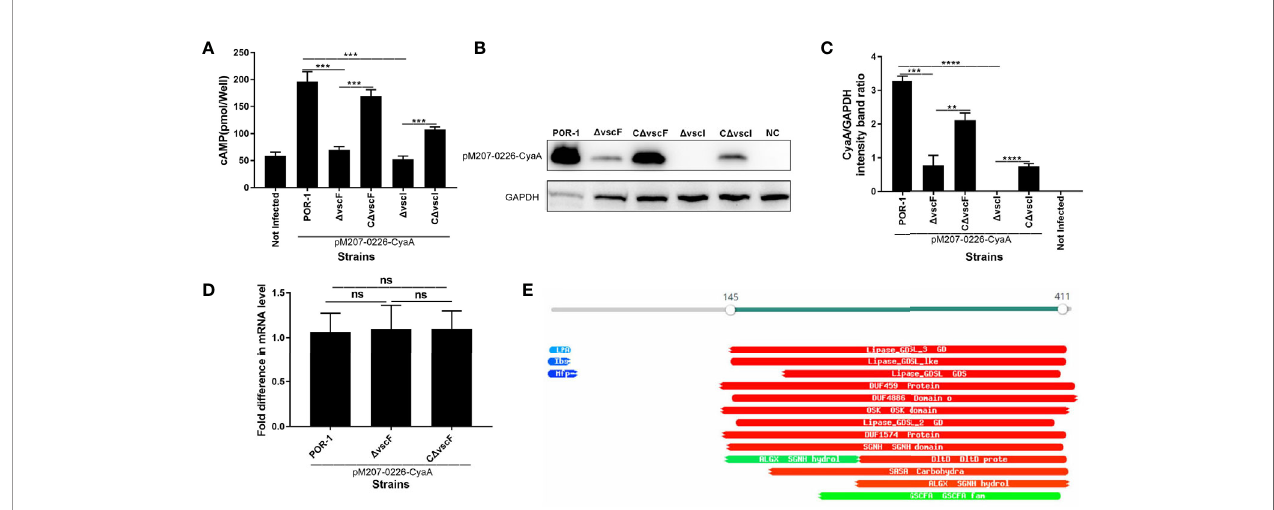
FIGURE 4 | vscF and vscI are involved in the secretion of VPA0226 in V. parahaemolyticus . Intracellular cAMP (A) and the translocated amounts of CyaA-fused protein (B) were quanti fi ed after infection with V. parahaemolyticus vscF and vscI mutant strains. GAPDH served as internal reference. “ + ” or “ - ” refers to a strain harboring pMMB207-vpa0226-CyaA expression vector (+) or not (-). Densitometry analysis was performed for relative quanti fi cation (C) . **** P < 0.0001, *** P < 0.001, and ** P < 0.01. Relative mRNA transcription levels of vpa0226 genes in POR-1, D vscF and C D vscF strains. For each sample, the acquired cycle threshold (CT) was normalized to the CT of the internal housekeeping gene 16s RNA, and the D CT was normalized to the D CT of the POR-1 strain. Relative fold differences in mRNA expression level were calculated using the 2 − DD CT method (D) . Schematic illustration of the conserved domains of the predicted effector encoded by vpa0226. The predicted domains of VPA0226 harboring the typical GDLS lipase are indicated (E) . ns, indicates no signi fi cant